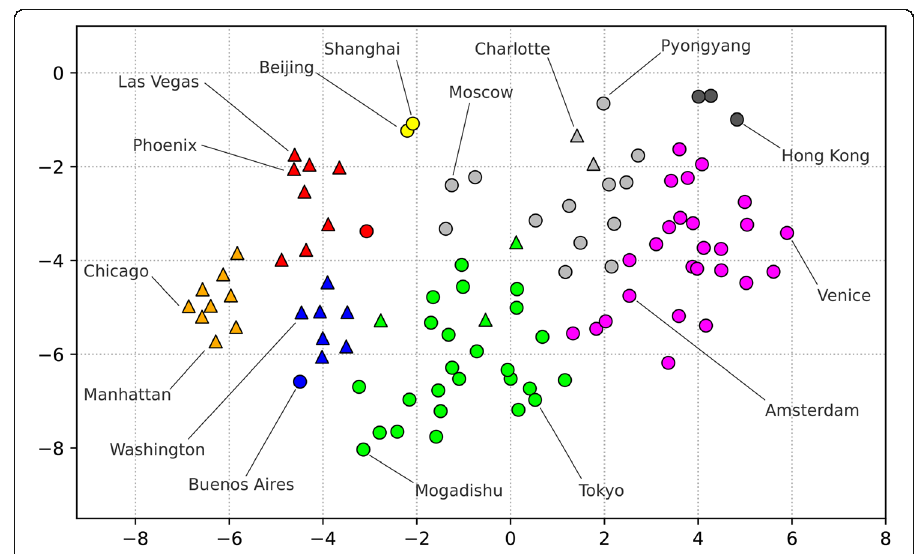
Fig. 7 Scatterplot of cities in two dimensions via t-SNE. Cluster colors correspond to Fig. 6. Triangles represent US/Canadian cities and circles represent other